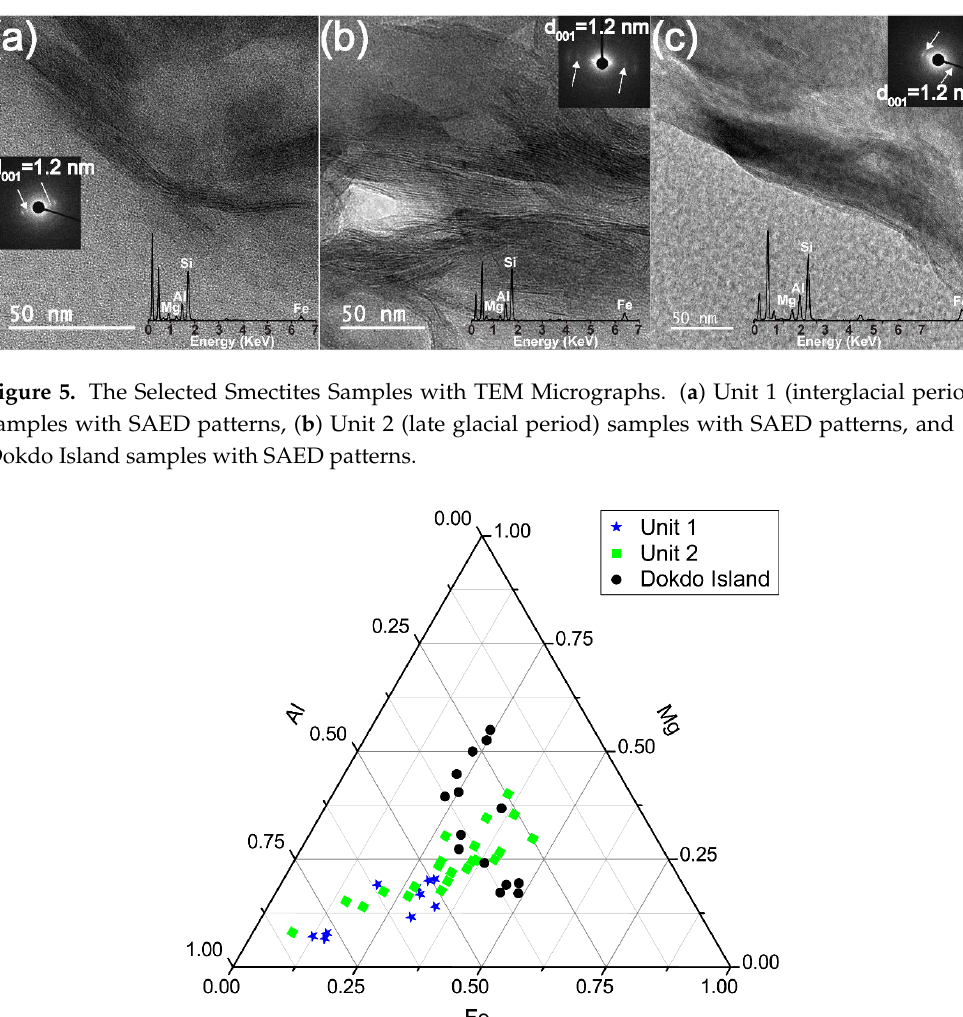
Figure 6. Ternary (Al-Fe-Mg) Diagram of the Octahedral Composition from Unit 1 (blue star), Unit 2 (green square), and Dokdo Island (black circle).